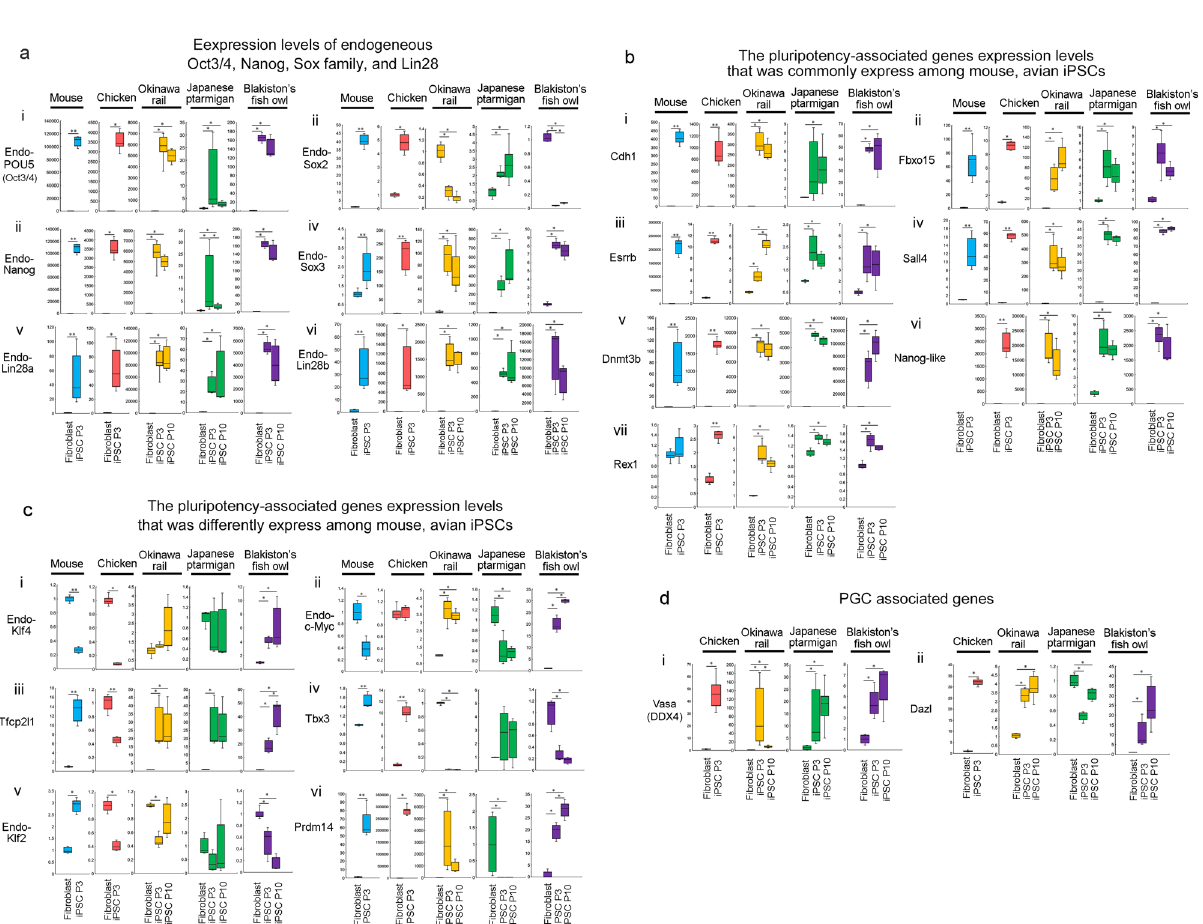
Fig. 2 Characteristics of the fi ve iPSCs. a Detection of reprogramming vectors using genomic PCR in mouse, chicken, Okinawa ral, Japanese ptarmigan, and Blakiston ’ s fi sh owl iPSCs. The PB-TAD-7F vector (i) and the Tsc2 internal control (ii) were detected. Lane M, molecular weight marker; lane C1, iPSC clone1, lane C2, iPSC clone 2; lane C3, iPSC clone 3; lane F, fi broblast; and lane sequence minus, PCR with sequence minus. b Detection of alkaline phosphatase (AP) activity in mouse (i), chicken (ii), Okinawa rail (iii), Japanese ptarmigan (iv) and Blakiston ’ s fi sh owl (v) iPSCs. The bars represent 200 μ m. Detection of stage-speci fi c embryonic antigen (SSEA)-1 ( c ) and -3 ( d ) in mouse, chicken, Okinawa rail, Japanese ptarmigan, and Blakiston ’ s fi sh owl iPSCs. SSEA-1 (i, iv, vii, x, and xiii), DAPI (ii, v, vii, xi, and xiv) and merged (iii, vi, ix, xii, and xv) image represent in ( c ), SSEA-3 (i, iv, vii, x, and xiii), DAPI (ii, v, vii, xi, and xiv) and merged (iii, vi, ix, xii, and xv) image represent in ( d ). The bars represent 200 μ m. e Detection of telomerase reverse transcriptase (Tert) expression by real-time PCR. Tert expression was quanti fi ed relative to the GAPDH internal control. The fi broblast expression level was 1.0. Light blue bars are mouse; pink bars are chicken; orange bars are Okinawa rail; light green bars are Japanese ptarmigan; and light purple bars are Blakiston ’ s fi sh owl-derived cells. Mouse and chicken: The bars represent fi broblasts and iPSCs (passage number 3; P3). Okinawa rail, Japanese ptarmigan, and Blakiston ’ s fi sh owls: bars represents fi broblasts, iPSCs (P3) and iPSCs (P10). Centerlines of box plots indicate medians; box limits indicate the 25th and 75th percentiles as determined by BoxPlotR (http://shiny.chemgrid.org/boxplotr/). n = 4 (chicken fi broblast), n = 6 (other). * P < 0.05, ** P < 0.01. f Passaging of mouse, chicken, Okinawa rail, Japanese ptarmigan, and Blakiston ’ s fi sh owl-derived iPSCs. g Cell growth analysis of established mice, Okinawa rail, and Japanese ptarmigan-derived iPSCs. The blue triangles represent iPSCs clone 1, red circles represent iPSCs clone 2, green squares represent iPSCs clone 3, and orange circles represent fi broblasts. We seeded 5 × 10 4 iPSCs or fi broblasts on the culture plate and harvested them when growth was con fl uent.